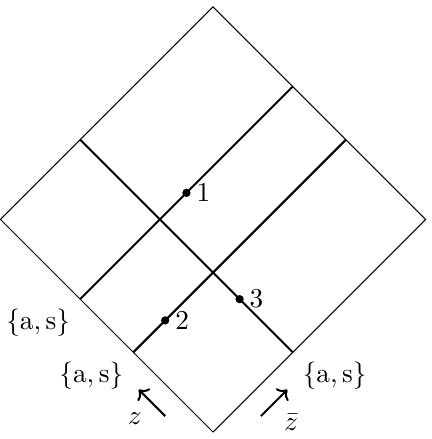
Figure 3 . The causal dependence of the 3-point correlators is controlled by the linking of the null rays over which the light transforms are performed. Because the signs of the helicity determine which lightcone direction is integrated over, different assignments of ‘a’ and ‘s’ can lead to 3-point correlators with OPE coefficients that are not symmetric under exchanging the puncture